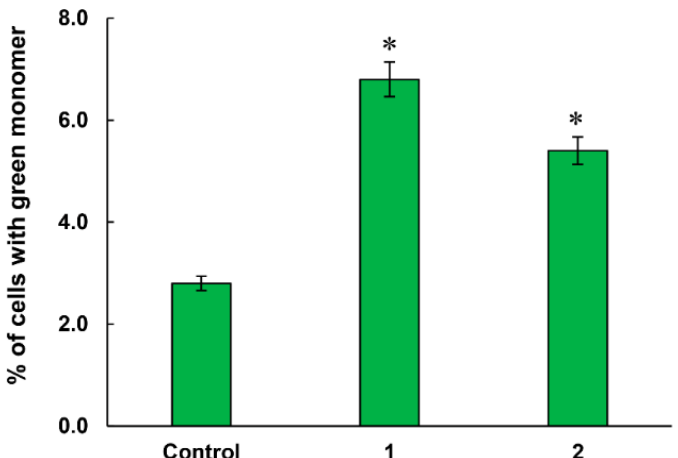
Figure 5. Quantitative determination of % cells with green monomers; 1 – 2а at IC 50 /2 concentration (12.5 µM); 2 – 2а at IC 50 concentration (25 µM). Values are presented as mean ± SD; ( ∗ ) p < 0.05 compared to control.